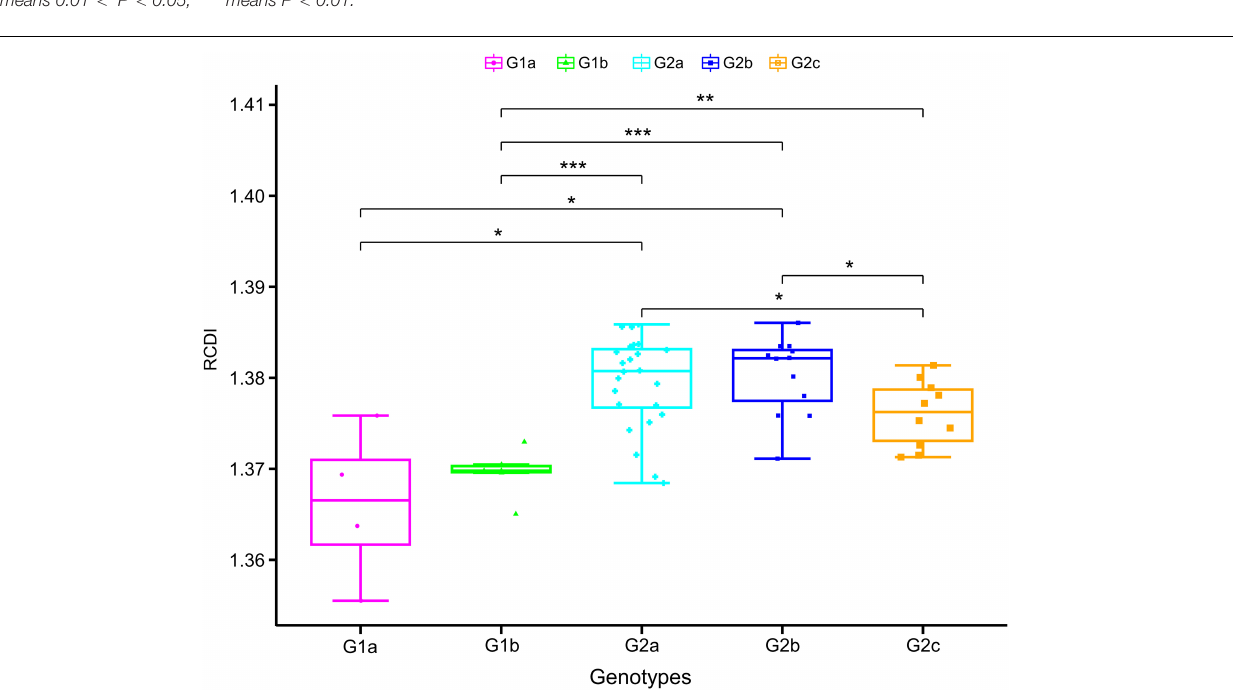
FIGURE 8 | Measures of PEDV adaptation in Sus scrofa . The relative codon deoptimization index (RCDI) analysis of PEDV coding sequences in relation to its hosts. In the plot, the abscissa represents the phylogroups, the ordinate represents the RCDI value. One-way ANOVA and Dunnett’s test were employed to compare the mean of the RCDI values pertaining to the different phylogroups. Asterisk indicated the differential RCDI value of PEDV between G1 and G2 is statistically significant or very significant ( p < 0.001 or p <